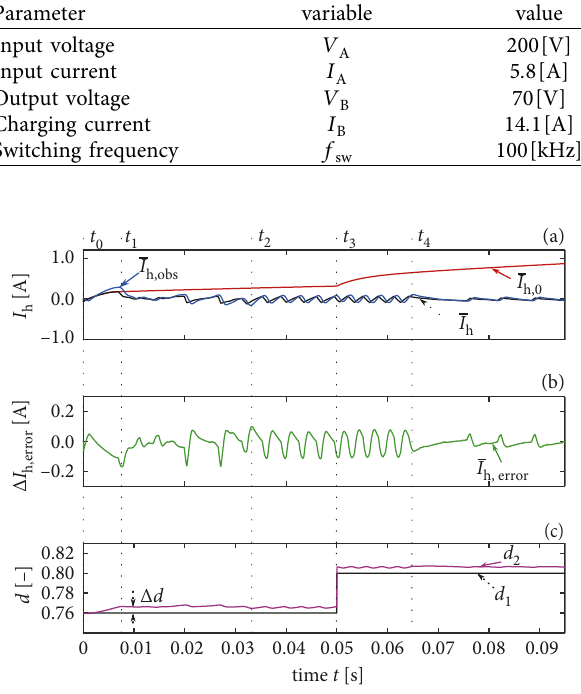
Figure 8: Evaluation of observer model. (a) shows the simulated average current I and the estimated observer current I h h , obs compared to the uncontrolled current I . (b) shows the model h , 0 error Δ I between I and modeled I . (c) shows the in- h , error h h , obs and d with offset fluence of ctr Ih on controlled variable with d 1 2 Δ d ≈ 0 .